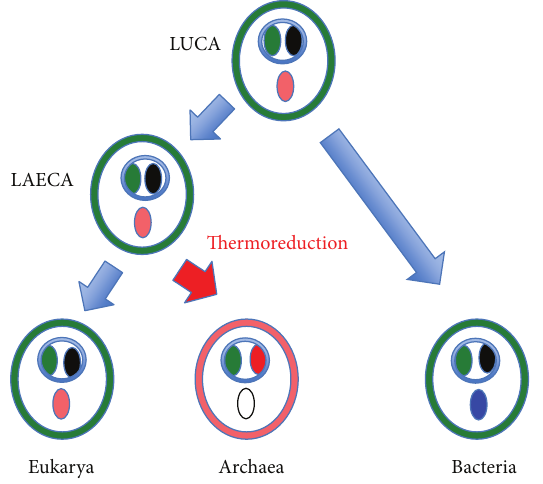
Figure 4: Schematic evolution of cellular membranes. Distribution of proteins involved in phospholipid biosynthesis in the three domains, LUCA, and LACA are depicted according to Lombard et al., [18, 22], but my evolutionary interpretation is different from those proposed by these authors [22]. Bacterial/eukaryal type membranes are in green and archaeal type membrane in red. Green circles correspond to universal enzymes involved in phospholipid biosynthesis (glycerol phosphate dehydrogenases, enzymes linking polar head groups to glycerol). Pink circles correspond to the classical mevalonate pathway for isoprenoid biosynthesis that was probably present in LUCA and lost in bacteria. Red circle represents enzymes of the alternative mevalonate pathway, which are specific of archaea, and involves a mixture of eukaryotic-like and archaeal specific enzymes. Blue circles correspond to the nonhomologous methylerythritol pathway for isoprenoid biosynthesis present in bacteria. Black circles represent the fatty acid biosynthetic pathway, which is no longer used for membrane phospholipid biosynthesis in archaea. Circles corresponding to proteins involved in the biosynthesis of membrane phospholipids are